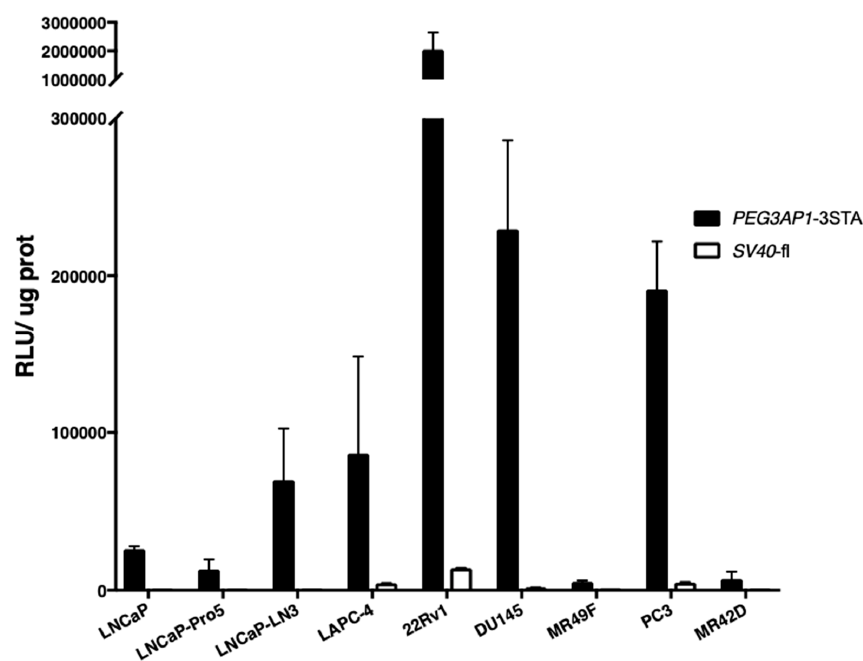
Figure 3. Activity of PEG3AP1 -3STA in a wide spectrum of prostate malignancies. PEG3AP1 -3STA relative luciferase activity was quantified in epithelial cells that were castration-sensitive (LNCaP, LNCap-Pro5, LNCaP-LN3, and LAPC4) and castration-resistant (22Rv1, DU145, and MR-49F), as well